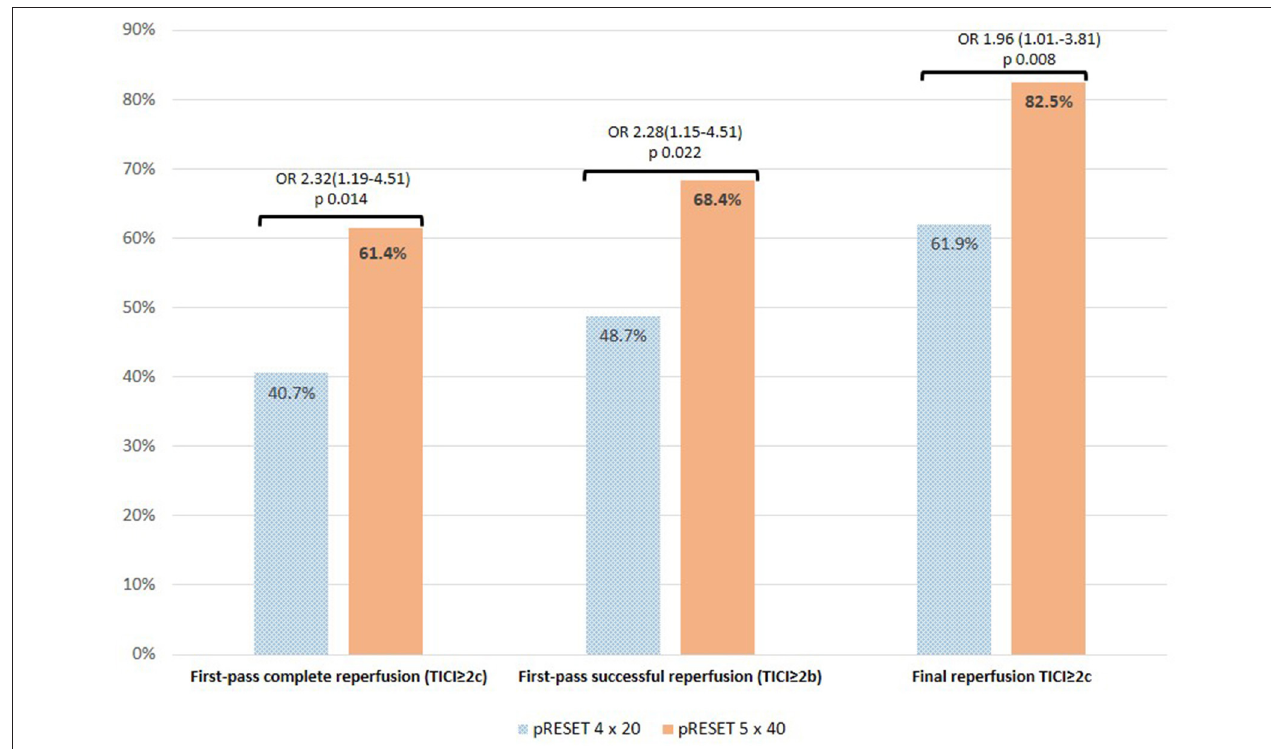
FIGURE 1 | pRESET 5 × 40 vs. pRESET 4 × 20 in M1-MCA occlusions: primary and principal secondary outcomes. Abbreviations: M1-MCA, M1 segment of middle cerebral artery; TICI, modified thrombolysis in cerebral infarction score; first-pass complete reperfusion (TICI ≥ 2c) and first-pass successful reperfusion (TICI ≥ 2b) are abbreviated in text as FP and mFP, respectively. Statistics: Fisher exact test; odds ratio (OR) and 95% confidence interval